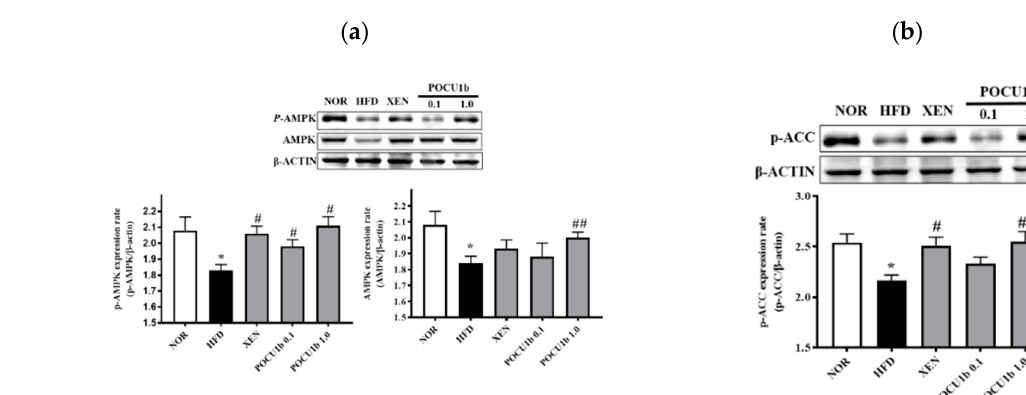
Figure 7. E ff ects of POCU1b on levels of adiponectin, leptin, IL-6, and TNF- α in the serum and / or liver in HFD-fed rats. ( a ) Serum adiponectin and ( b ) leptin levels. ( c ) IL-6 level in the serum and ( e ) expression in the liver. ( d ) TNF- α level in the serum and ( f ) expression in the liver. Serum adiponectin, leptin, insulin, TNF- α , and IL-6 levels were quantified using commercial ELISA kits. Protein expression was measured by Western blot analysis. * p < 0.05, ** p < 0.01, *** p < 0.001 vs. NOR, # p < 0.05, ## p < 0.01, ### p < 0.001 vs. HFD.